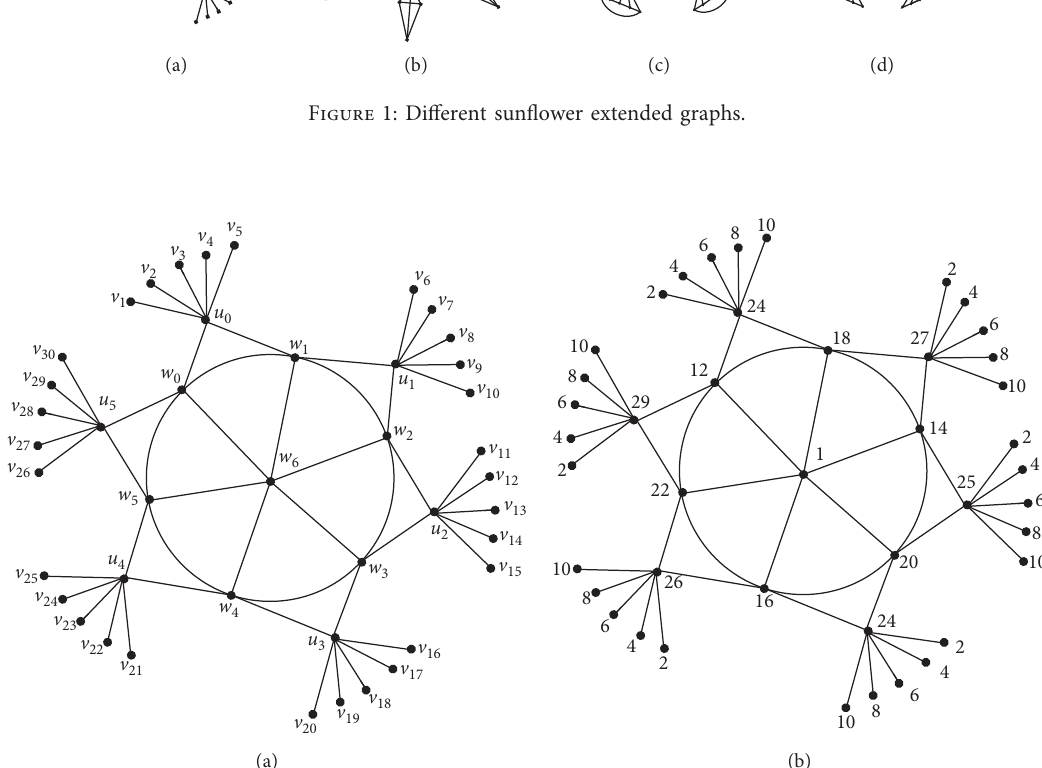
Figure 2: A sun-star graph SS ( 6 , 5 ) and its radial radio